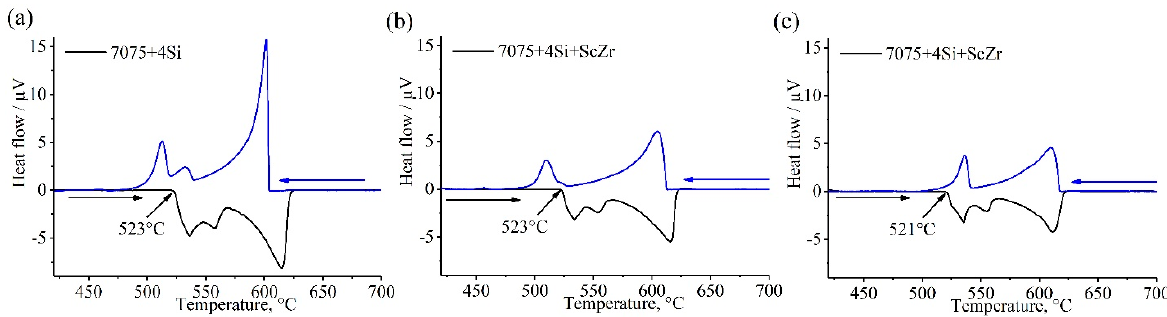
Figure 4. DSC curves of the investigated alloys; ( a ) 7075-4%Si, ( b ) 7075-4%Si + ScZr, and ( c ) 7075-4%Si + TiB.